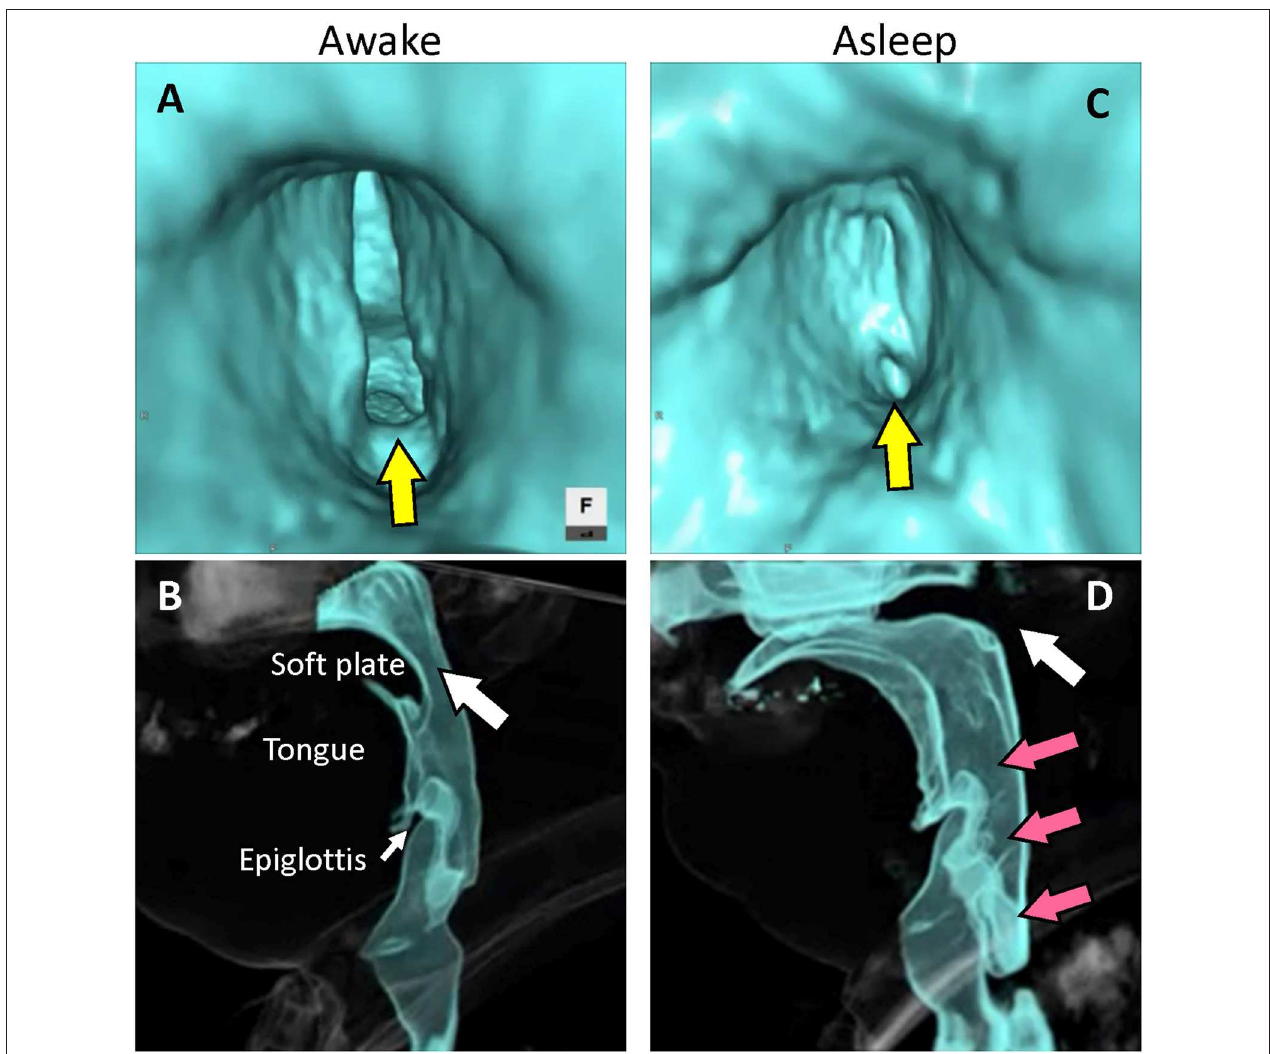
FIGURE 2 | Reconstructed images of four-dimensional computed tomography. (A) Virtual endoscopic image from the subglottic view. The glottis remains open at the terminal stage of inspiration during wakefulness (yellow arrow). (B) Lateral view. The velopharyngeal space remains open at the initial stage of exhalation during wakefulness (white arrow). (C) Virtual endoscopic image from the subglottic view. The glottis closes at the terminal stage of inspiration during sleep (yellow arrow). (D) Lateral view. The soft plate becomes elevated and velopharyngeal closure occurs at the initial stage of exhalation during sleep (white arrow) with expansion of the pharyngeal space (red